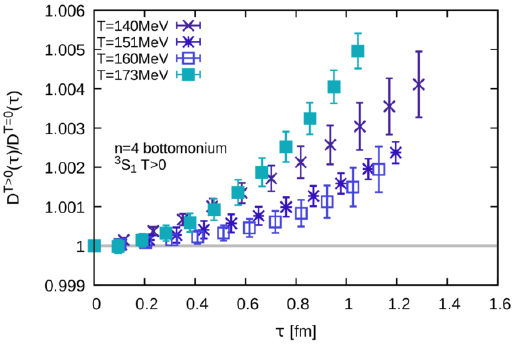
Figure 17 . Low temperature region of the bottomonium 3 S 1 channel. Note the non-monotonous behavior around T c and the fact that already in the hadronic phase the ratio deviates from